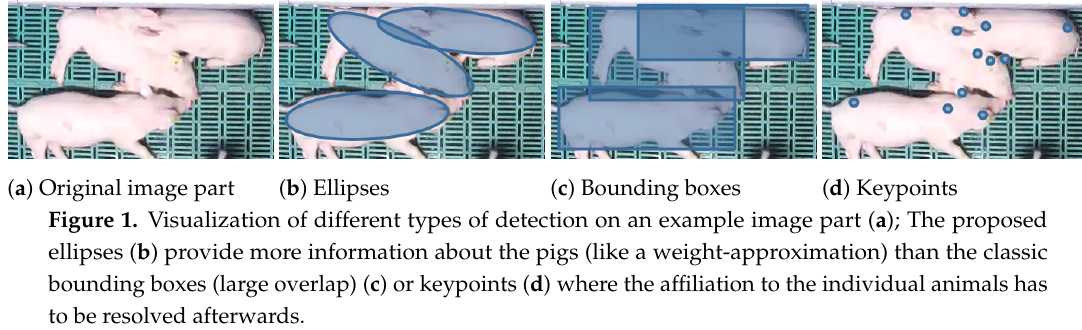
Figure 1. Visualization of different types of detection on an example image part ( a ); The proposed ellipses ( b ) provide more information about the pigs (like a weight-approximation) than the classic bounding boxes (large overlap) ( c ) or keypoints ( d ) where the affiliation to the individual animals has to be resolved